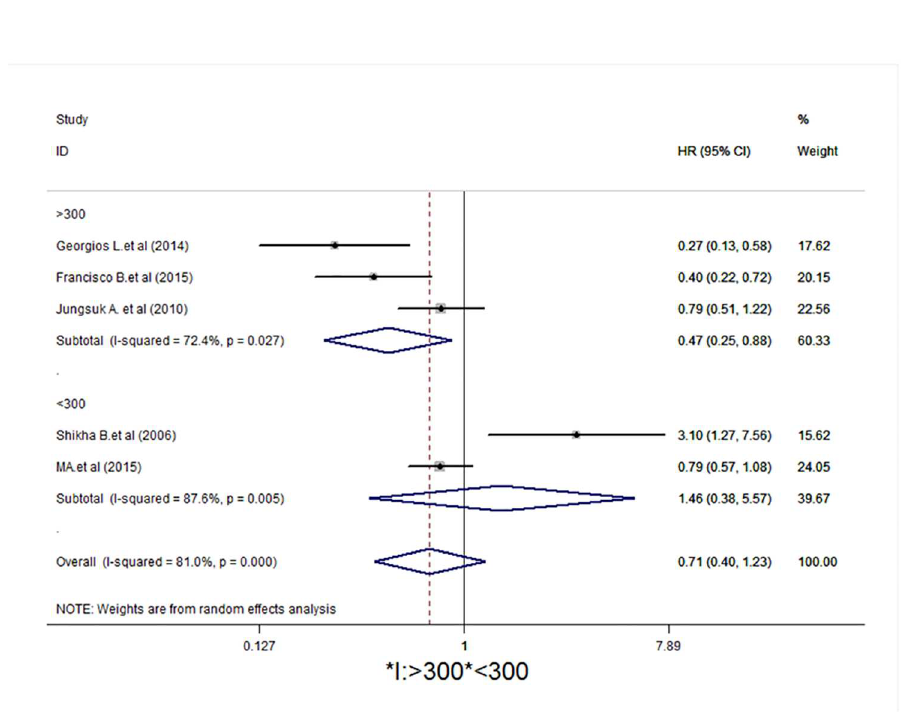
Fig 6. Subgroup analysis indicates statistical significance in the subgroup of > 300 patients. Forest plot showingthe associationbetweenp-mTOR expressionand disease-free survival of breast cancer patients from the random-effects